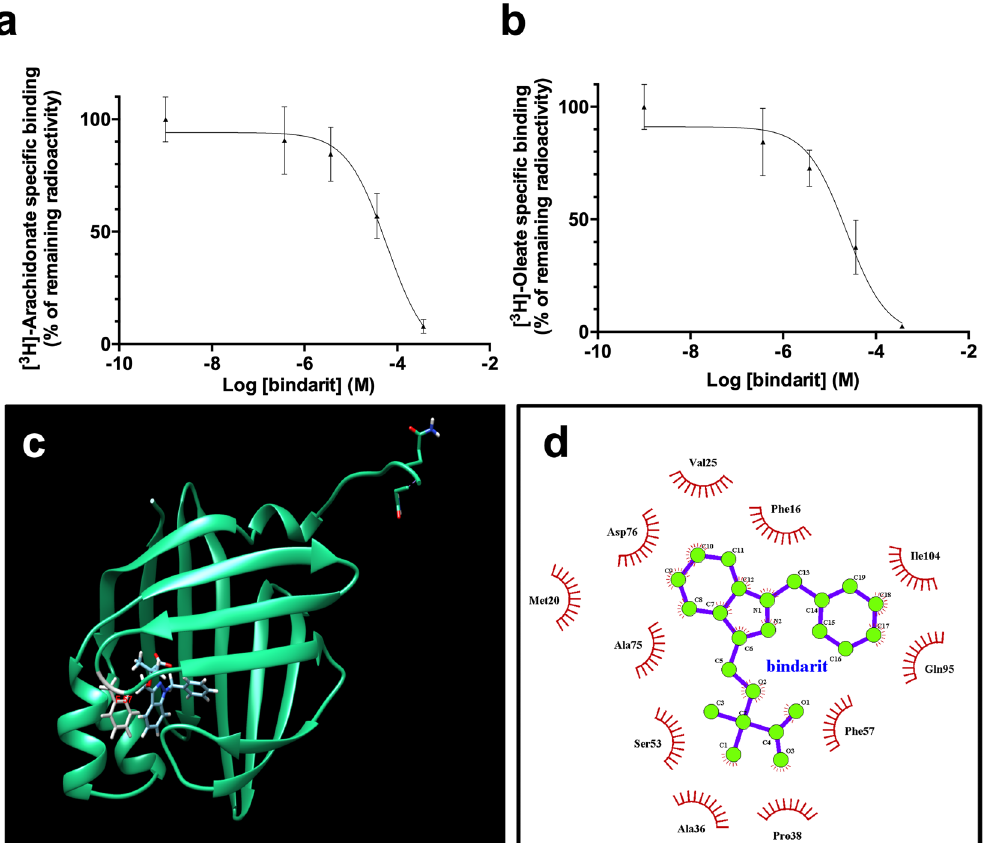
Figure 2. In vitro and in silico studies of the physical interaction between human FABP4 and bindarit. Displacement of [ 3 H]-arachidonic ( a ) and [ 3 H]-oleic acid ( b ) from the binding site of human FABP4 by bindarit. Displacement curves were fit to a one-site model with Ki values of 19 μ M and 60 μ M for arachidonate and oleate, respectively. The graphed points represent the means ± S.D. of 2 independent experiments, each performed in triplicate. ( c ) Bindarit has a binding mode similar to that of ibuprofen in the active site of human FABP4. Grey: residue Phe57, involved in the binding of small molecules. ( d ) 2D plot representation of the bindarit’s interactions with amino acid residues in the fatty acid binding pocket of the human